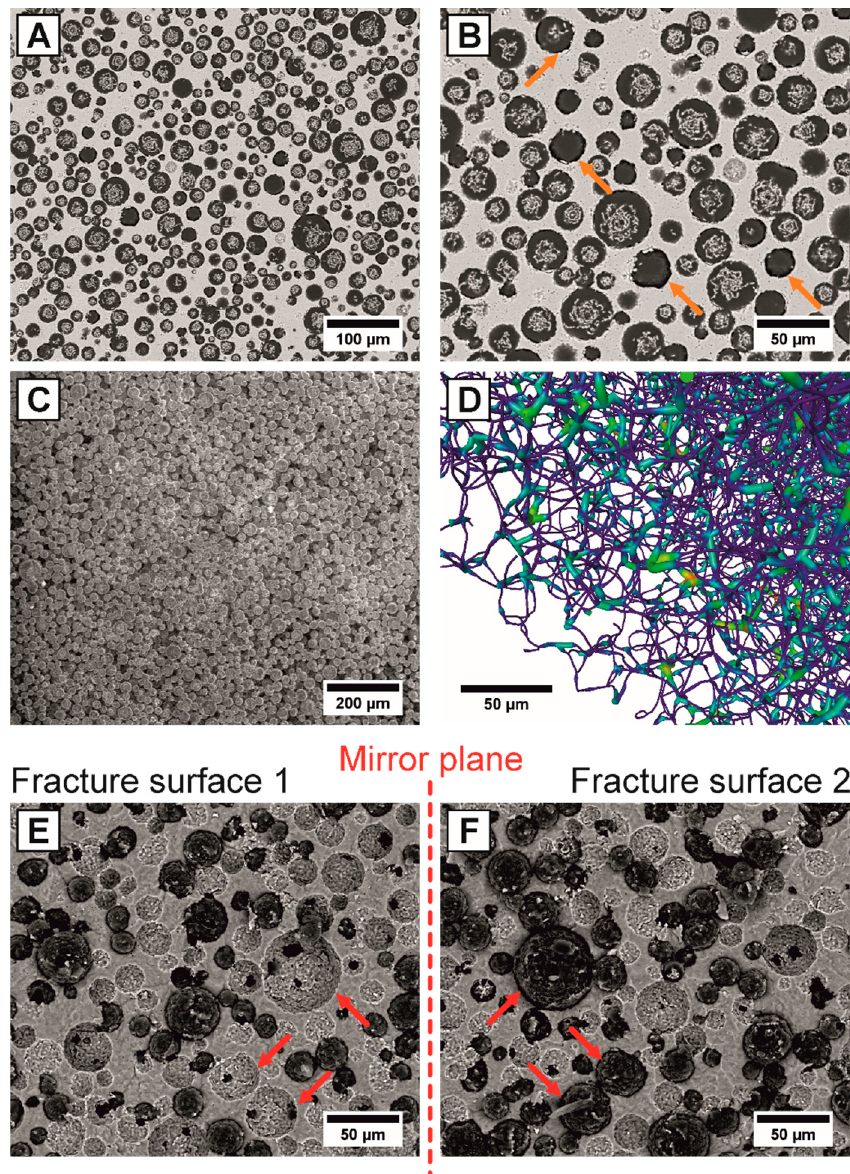
Figure 5. Microstructure of the fabricated HAp/UDMA composites with 40 Vol% of pore formers ( A , B ): SEM-micrographs show the complete polymer infiltration of all HAp pores ( A ) and polymerization shrinkage at the HAp/UDMA interface, highlighted by the orange arrows ( B ). Visualization of the interconnected UDMA-based polymer network ( C , D ): SEM-micrograph after etching-out the HAp ceramic matrix ( C ) and reconstructed, skeletonized µCT-polymer network indicating the pore sizes by a color heat-map with blue for pores >1 µm and red color >10 µm ( D ). Fracture behavior of the HAp/UDMA composites ( E , F ): The two fracture surfaces of one sample from the flexural testing, showing the fracture at the polymer/ceramic interface associated with 100% pullout effects of all polymeric spheres, highlighted as exemplary by three red arrows ( E , F ).